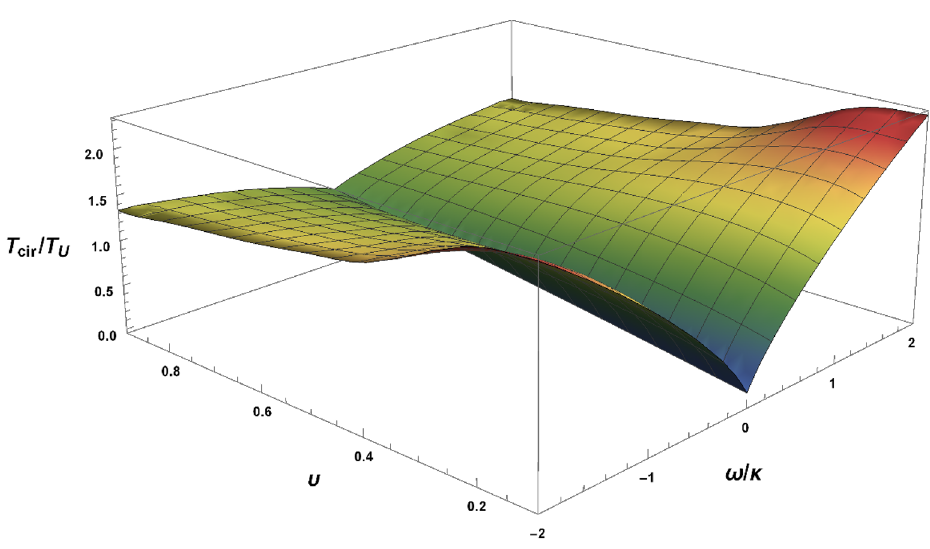
Figure 4 . The e(cid:11)ective temperature of a detector following a circular trajectory scaled to the Unruh temperature as a function of !=(cid:20) and the velocity 0 : 1 (cid:20) (cid:29) (cid:20) 0 : 9. In the limit !=(cid:20) ! 0, a slowly moving detector with velocity (cid:29) = 0 : 1 registers the coldest e(cid:11)ective temperature T e(cid:11) =T U (cid:25) 0 : 099. The lowest e(cid:11)ective temperature obtained by a detector moving with (cid:29) = 0 : 9 is T e(cid:11) =T U (cid:25) 0 : 84.